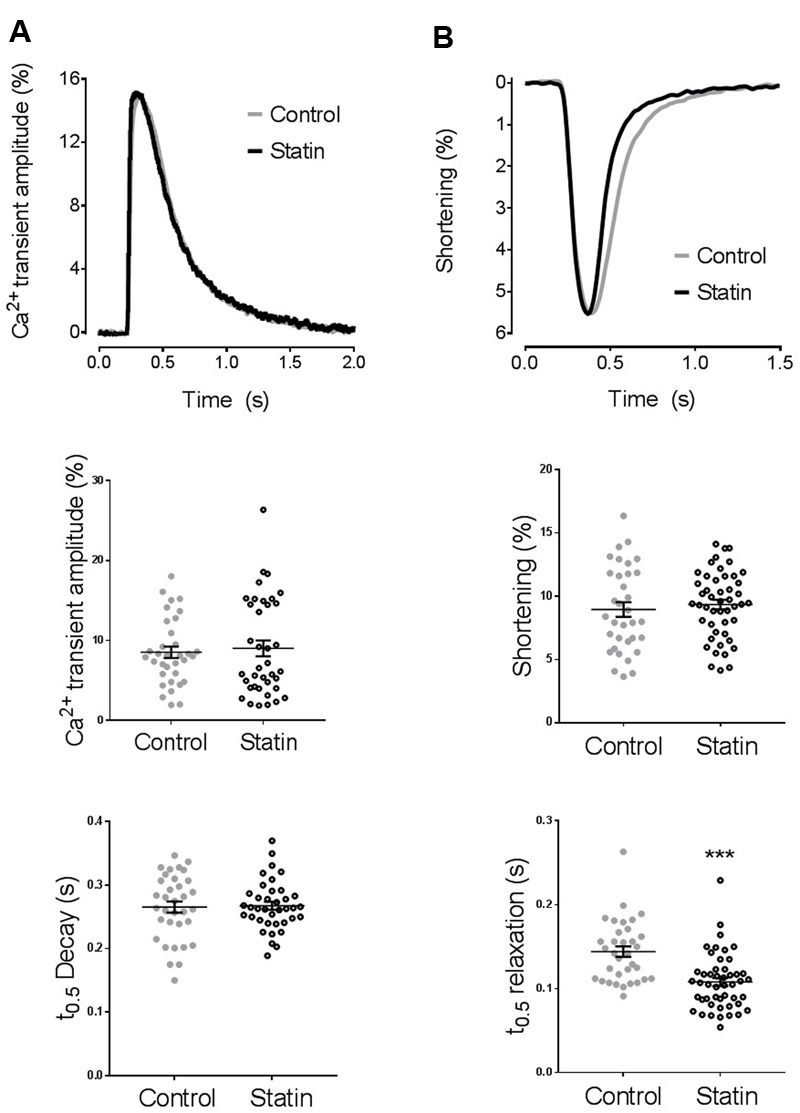
The effect of simvastatin treatment on [Ca2+]i transient and shortening. (A) Representative traces and scatter plots of amplitude and kinetics of the [Ca2+]i transient. Transient amplitude is expressed as % change in fura-2 ratio units (RU) over baseline. There was no difference in diastolic [Ca2+]i between groups (0.967 ± 0.008 vs. 0.976 ± 0.003 RU in cells from control and statin-treated animals respectively). n = 34–35 cells from 7 to 8 animals per group. (B) Representative traces and scatter plot of amplitude and kinetics of shortening. Shortening amplitude is expressed as % of resting cell length. There was no difference in resting cell length between groups (110 ± 2 vs. 110 ± 2 μm in cells from control and statin-treated animals respectively). Plots show mean ± SEM from n = 34–48 myocytes from 7 to 8 animals per group. ∗∗∗P < 0.001 vs. control group, Student’s t-test.